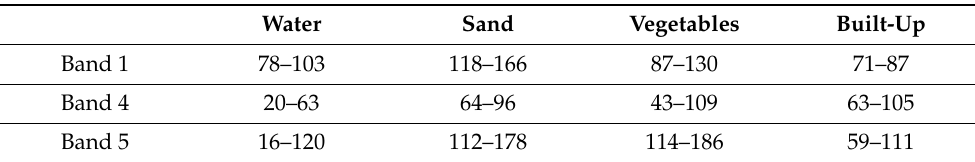
Table 2. Class-spectral-intensity range of training pixels.